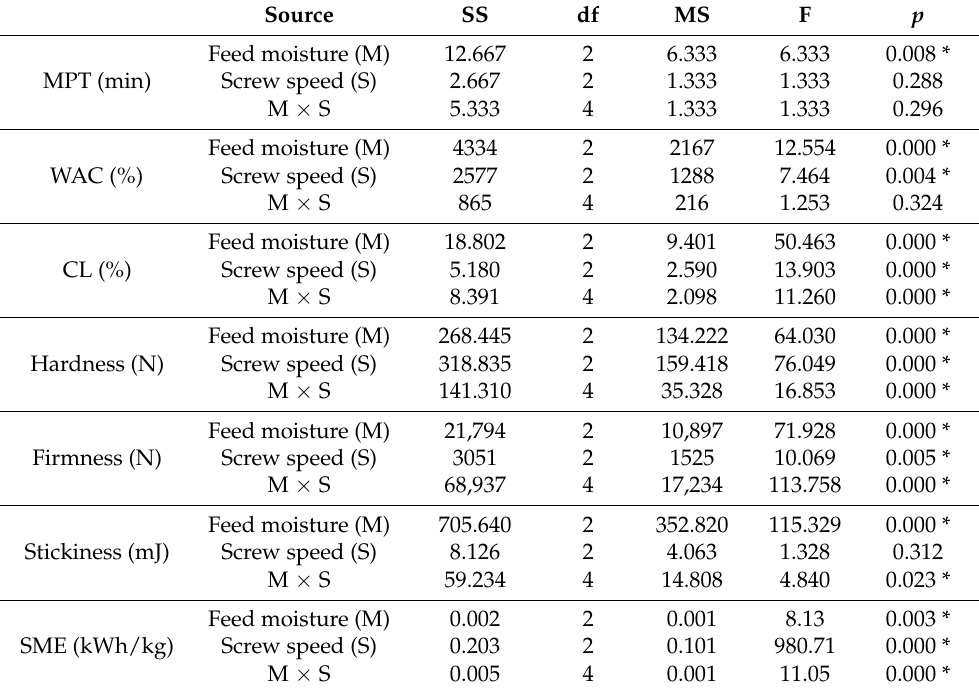
Table 1. Two-way ANOVA results for cooking quality, texture and energy